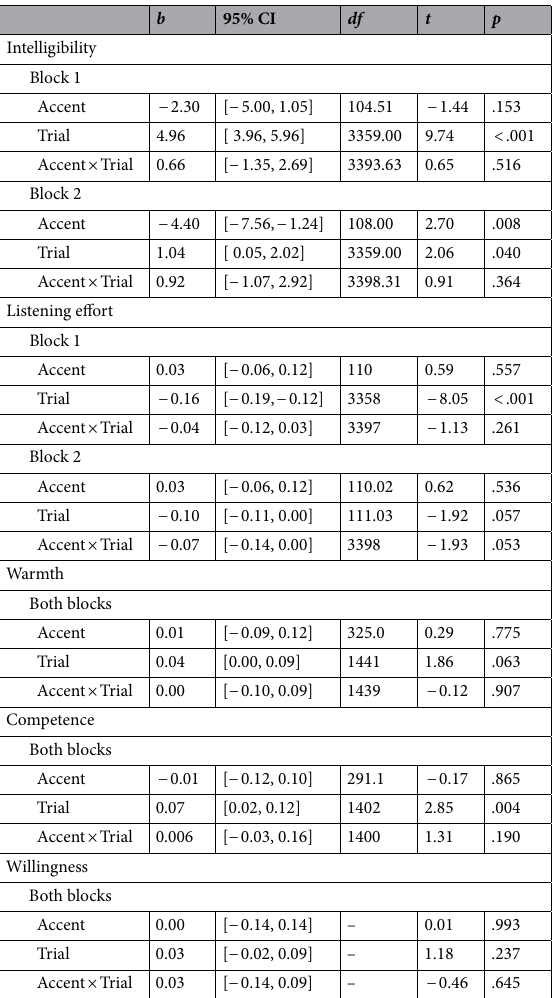
Table 2. Summary statistics for all relevant models. For intelligibility and listening effort, within each block, Accent served as a between-subjects independent variable. Effects involving Trial are scaled to 10